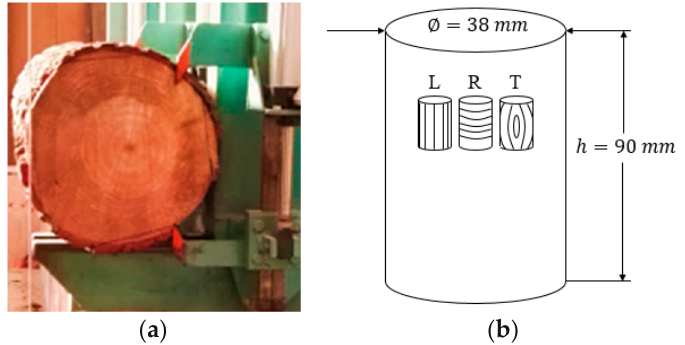
Figure 1. Obtaining samples: ( a ) cross section of the log. ( b ) Sample dimensions and anatomical directions. L: longitudinal, R: radial, T: tangential. Table 1. Thermophysical characteristics of the impregnant [23] and Pinus radiata wood properties. Property